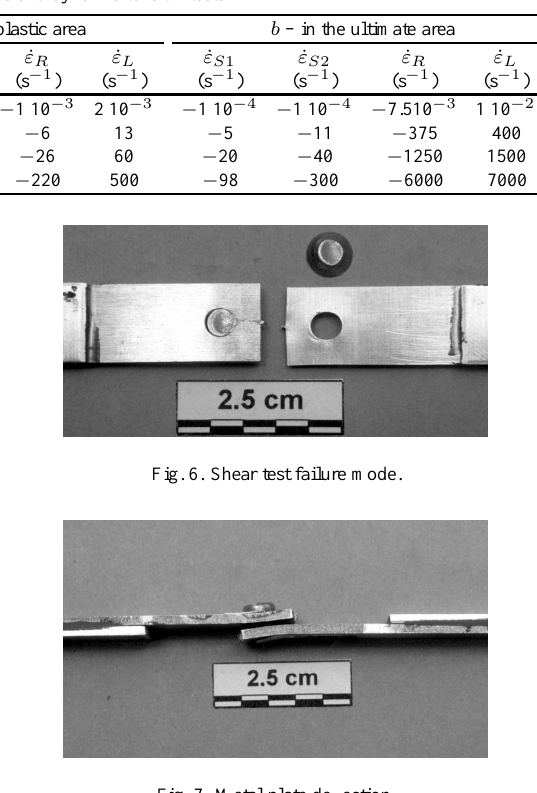
Fig. 7. Metal plate